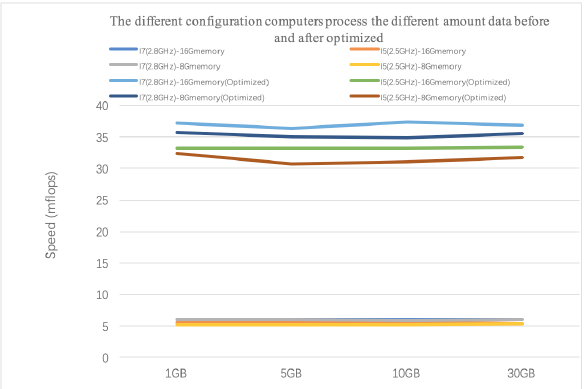
Figure 3. The different configuration computers process the different amount data before and after